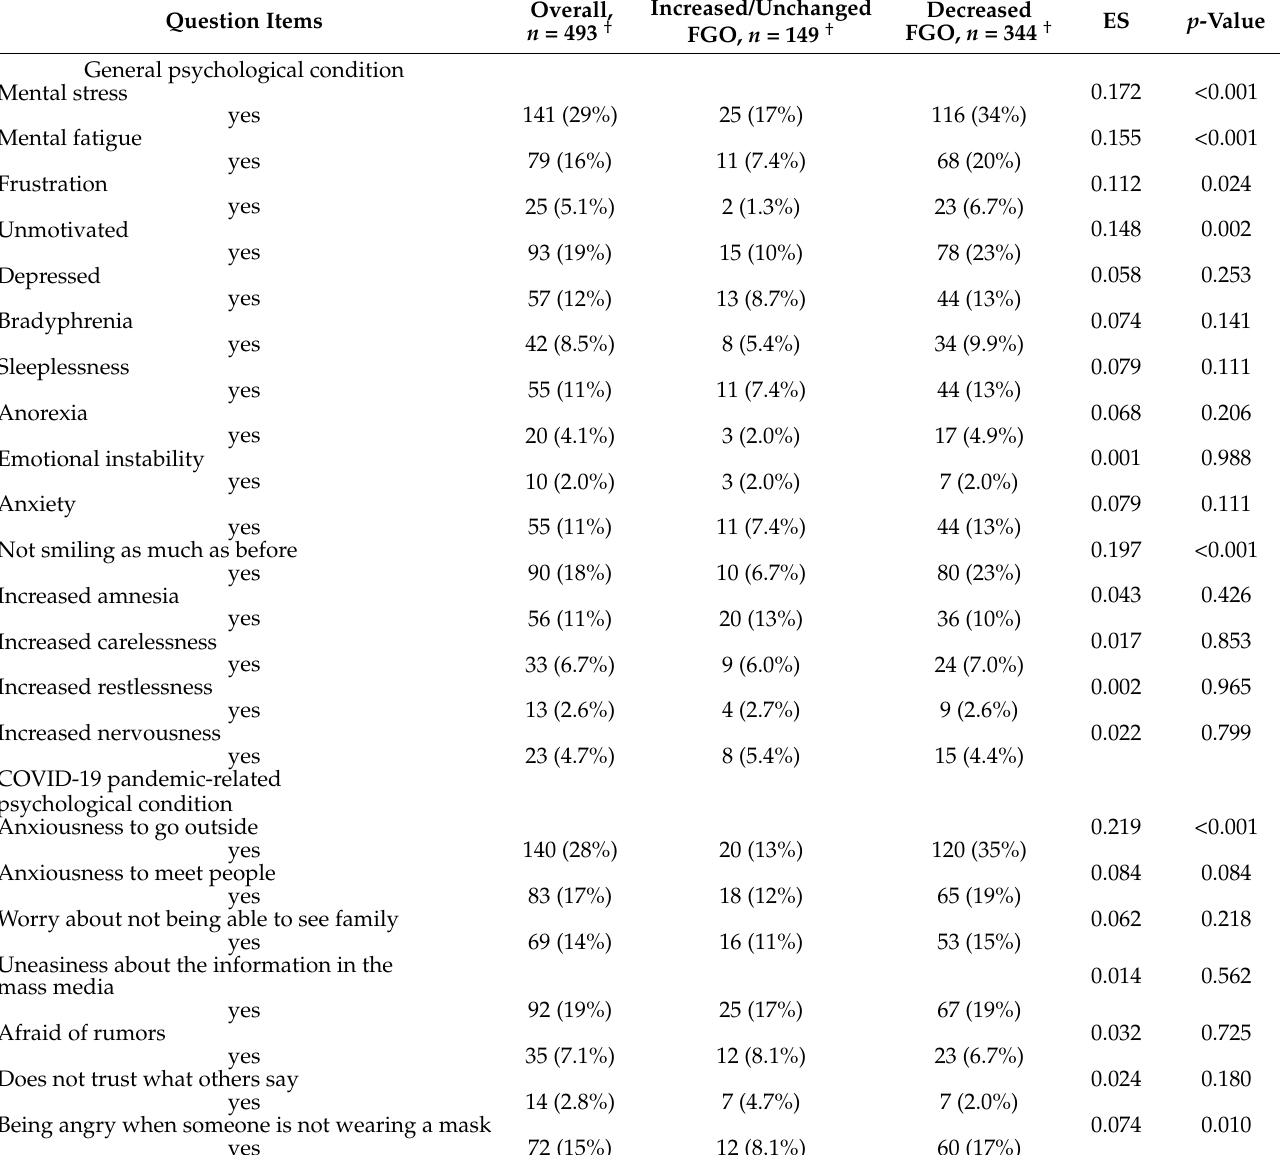
Table 3. Bivariate statistics for mental condition changed since before the COVID-19